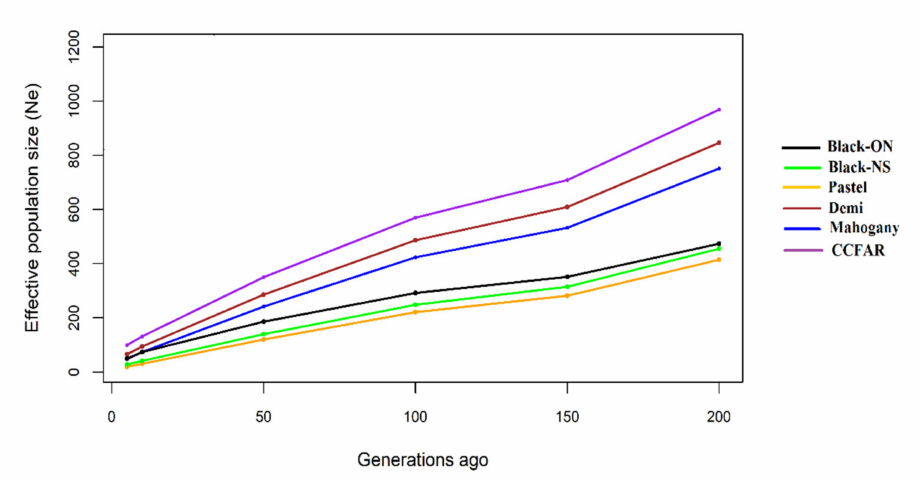
Figure 4. Estimated effective population sizes ( Ne ) for five color-types of American mink as a function of generations ago. Black-NS and Black-ON represent the black color-type samples collected from the Canadian Center for Fur Animal Research (Truro, NS, Canada) and Millbank Fur Farm (Rockwood, ON, Canada),